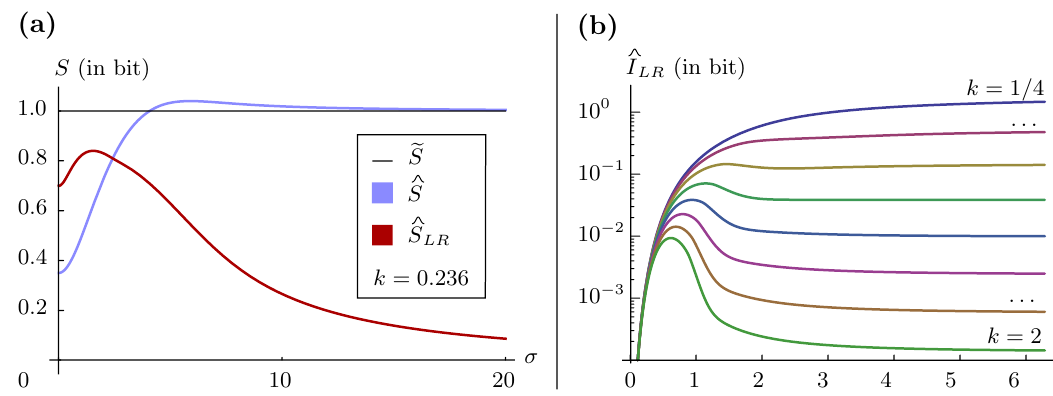
Figure 3 . (a) The entropy of: a Rindler wavepacket, a pair of Rindler wavepackets and a Rindler plane wave; all as a function of the length (cid:27) . The Rindler momentum k is chosen as to make e S (cid:25) 1 bit. (b) Log-lin plot of the mutual information of two Rindler wavepackets for various k with increments of 1 = 4, as a function of the length (cid:27)